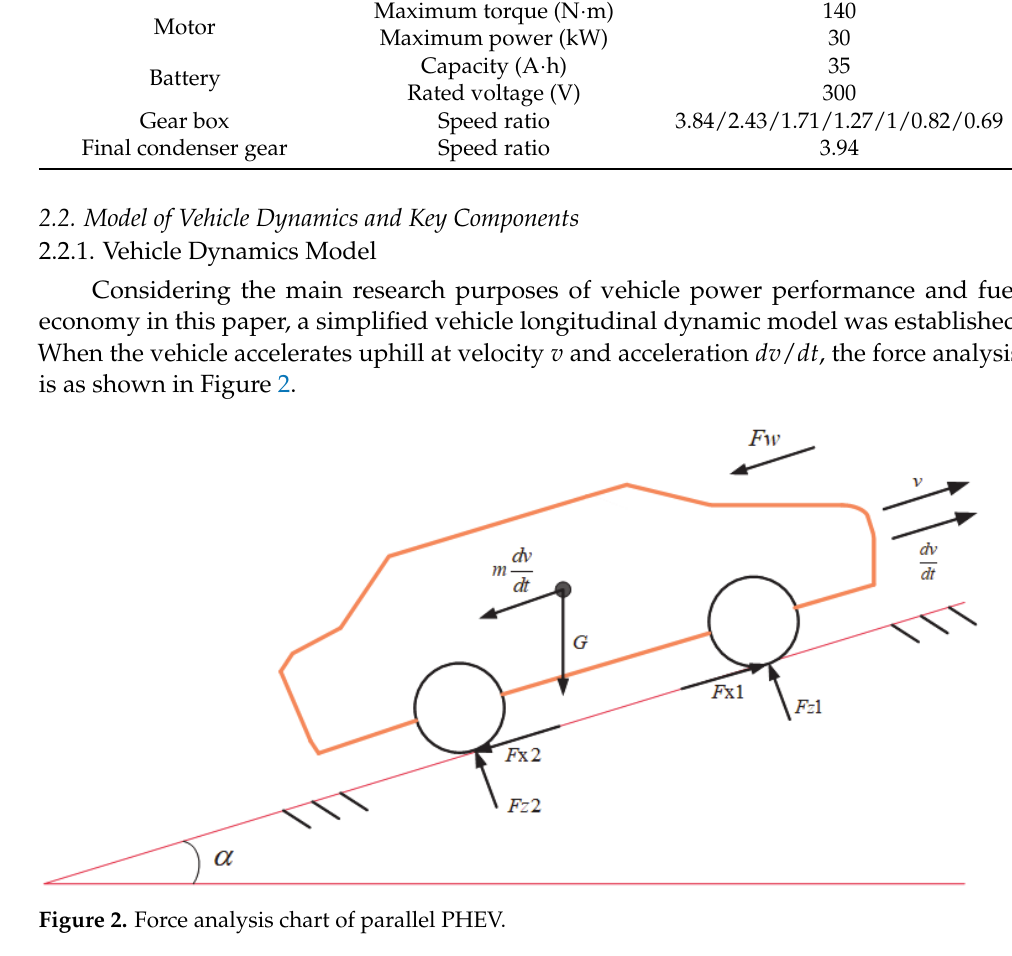
Table 1. Key component parameters.